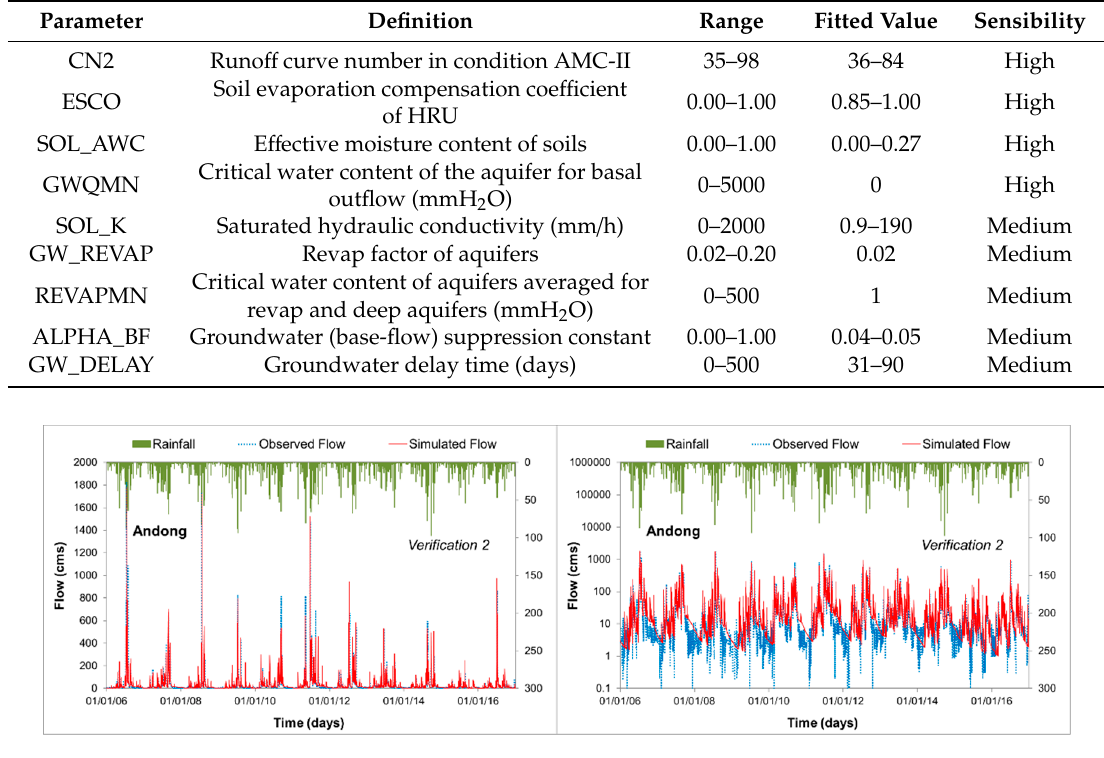
Table 4. Sensibility of Soil and Water Assessment Tool (SWAT) model parameters.